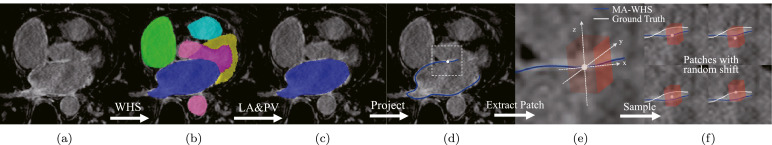
Pipeline of the projection and patch extraction phases: (a) target LGE MRI; (b) WHS result of LGE MRI propagated from Ana-MRI; (c) extracted LA and PV from WHS; (d) LA endocardial surface after projection; (e) patch along the normal direction of the LA endocardial surface; (f) patches with random shift in the training phase.